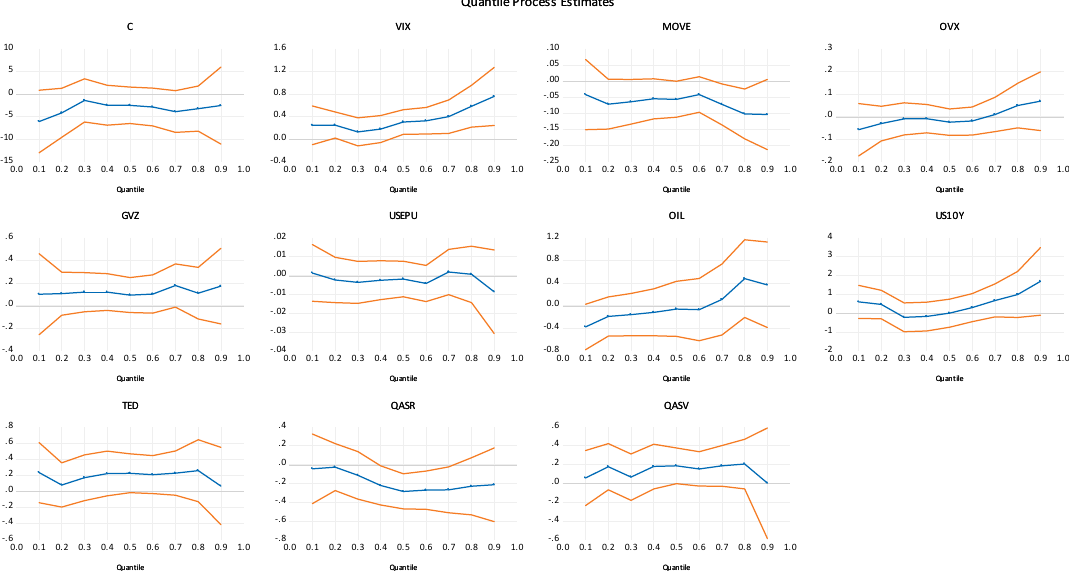
Figure 8. Quantile regression coefficient estimates in the case of Qatar, with 95% confidence intervals. Vertical axes show the coefficient estimates of the explanatory variable over the Qatar CDS spreads distribution. Horizontal axes show the quantiles of the dependent variable.